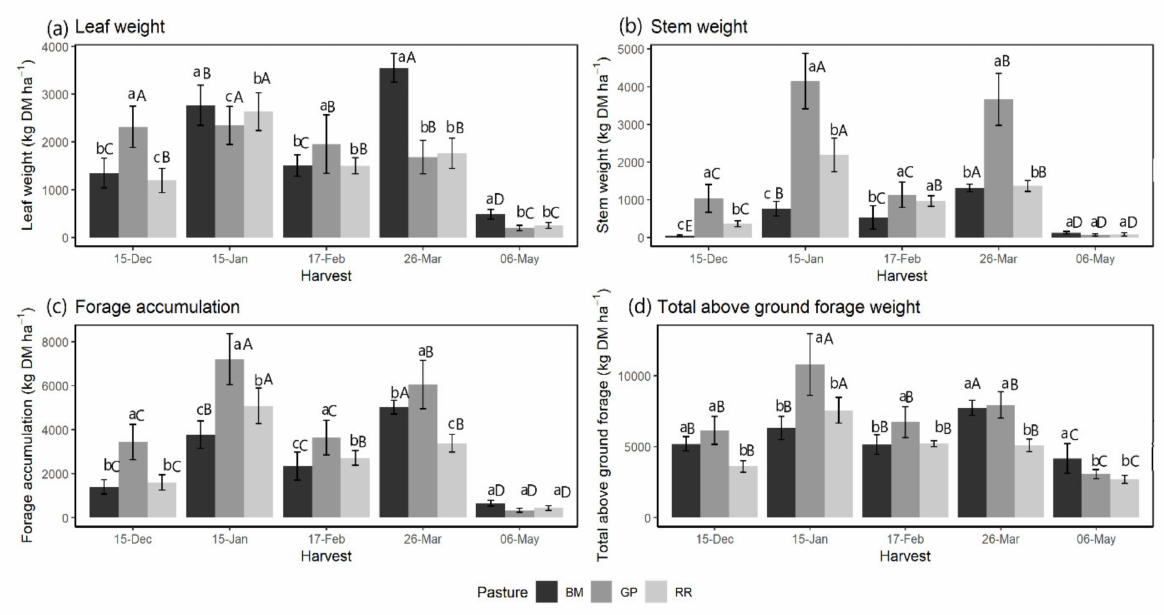
Figure 2. Leaf weight ( a ), stem weight ( b ), forage accumulation ( c ) and total above-ground forage yield ( d ) of Brachiaria Mulato II (BM), Gatton panic (GP), Rhodes grass Reclaimer (RR) measured Error bars represent the standard error of means (kg DM ha − 1 ). Different lowercase letters denote the significant difference of pasture species within same harvest and different uppercase letters denote the significant difference of pasture species between harvest at p <